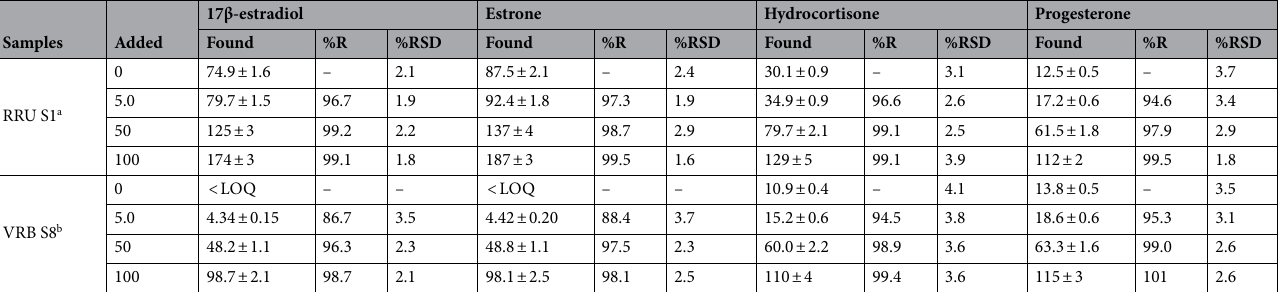
Table 3. Determination of steroid hormones in spiked river was samples. (average ± std deviation). a RRU SI: Rietspruit River upstream (before the wastewater treatment plant (WWTP). b VRB S8: Vaal River before Rietspruit River